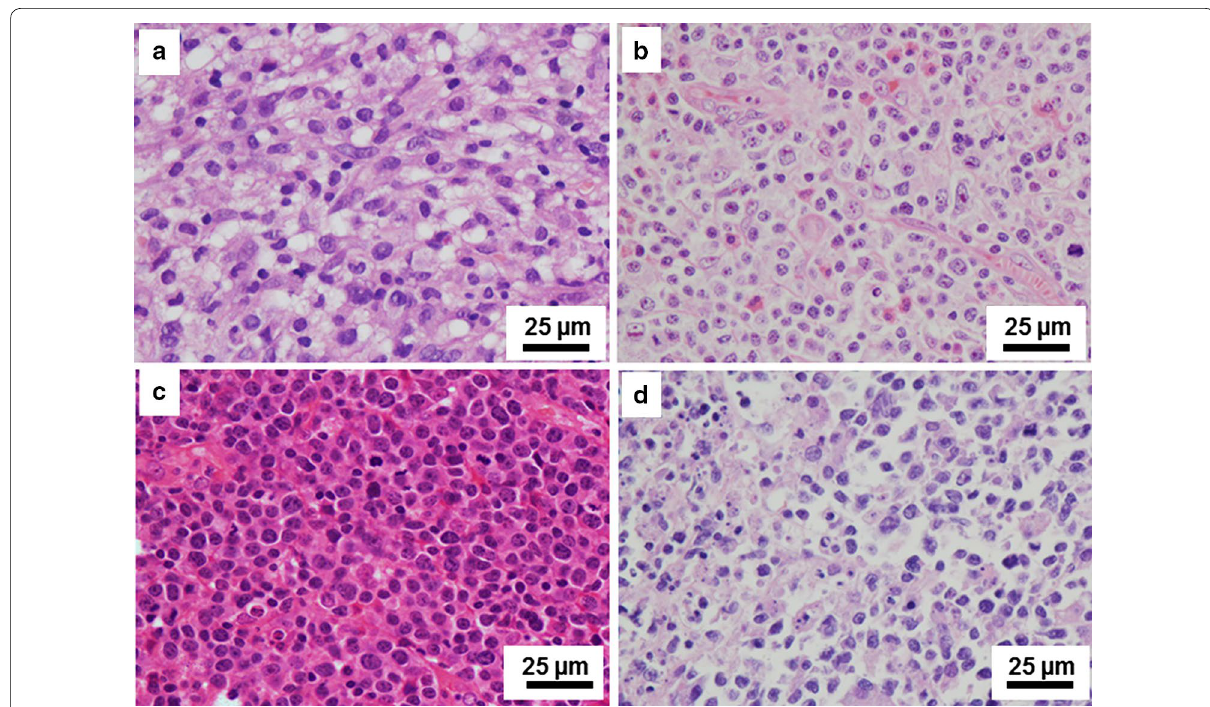
Fig. 1 Morphology of different subtypes of T-cell and natural killer (NK)-cell lymphoma (hematoxylin–eosin staining, cell lymphoma, nasal type (ENKTL) shows medium-sized tumor cells with apoptotic bodies. b Angioimmunoblastic T-cell lymphoma (AITL) shows proliferation of high endothelial venules, polymorphic infiltrating cells, and cells with clear-to-pale cytoplasm. c Peripheral T-cell lymphoma, not otherwise specified (PTCL-NOS) shows medium- to large-sized polymorphic tumor cells with high mitotic figure rates. d Anaplastic lymphoma kinase (ALK)-positive, anaplastic large-cell lymphoma (ALCL) shows cells with horseshoe or kidney-shaped nuclei and inflammation